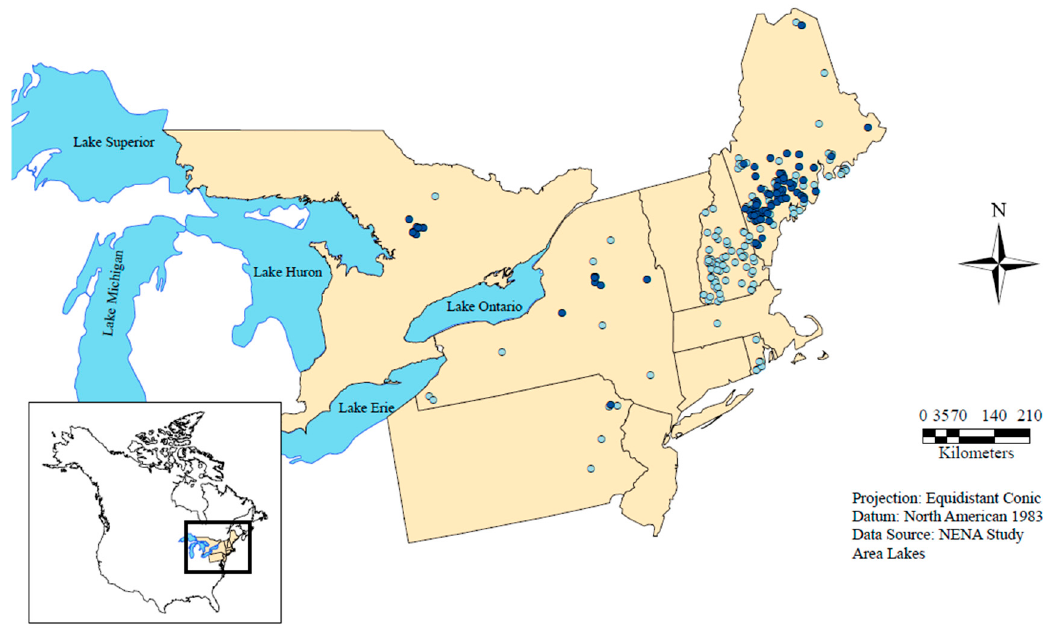
Figure 1. Location of study lakes for the northeastern North America (NENA) study. The 1975 cohort of lakes (centroids) is depicted as dark blue circles ( n = 85), and the 1985 cohort of lakes is depicted as light blue circles ( n = 226). Note that the 1975 cohort of lakes includes the 1985 cohort of lakes (except for five lakes).